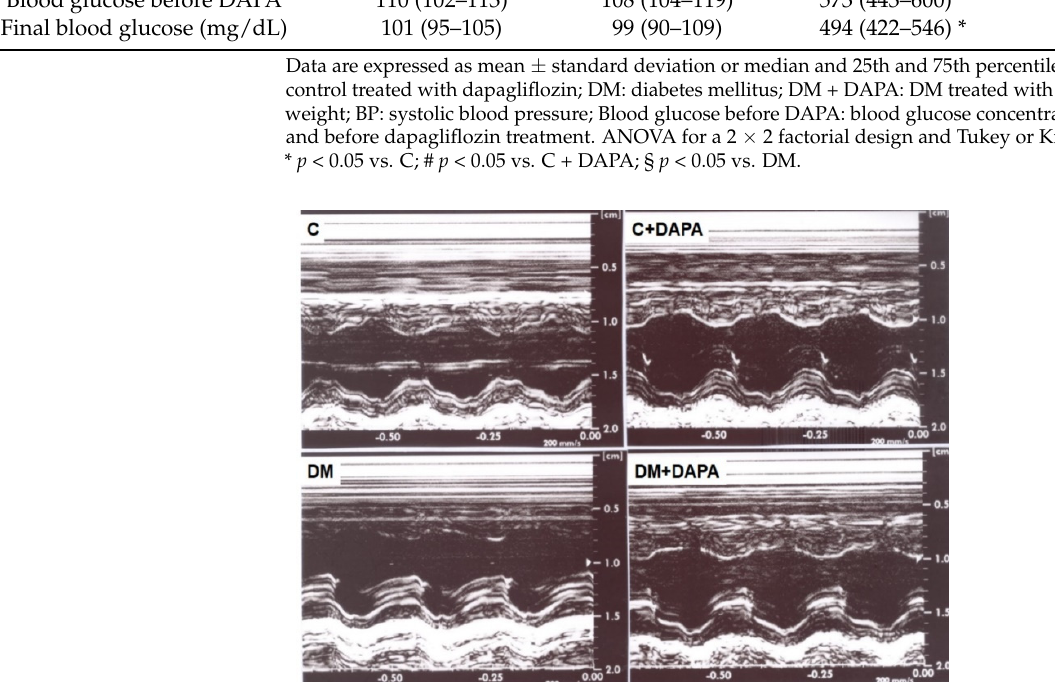
DAPA: control treated with dapagliflozin; DM: diabetes mellitus; DM + DAPA: DM treated with dapagliflozin; DM: diabetes mellitus; DM + DAPA: DM treated with dapagliflozin.